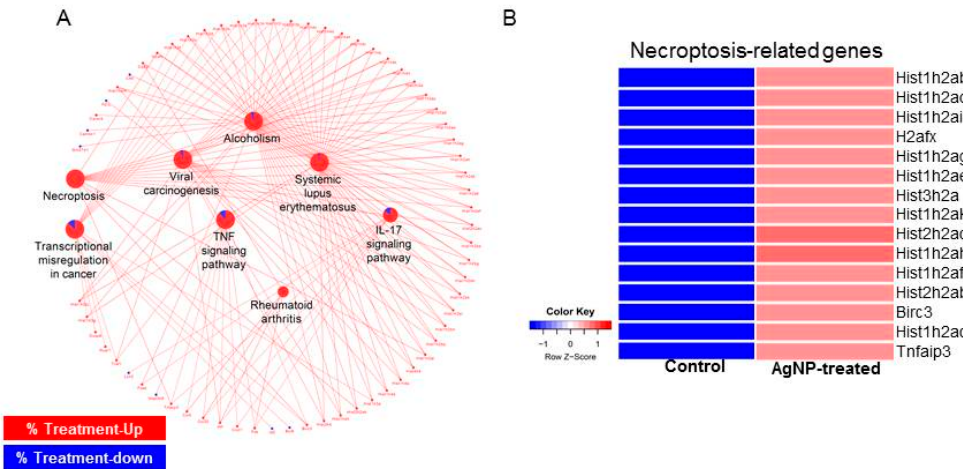
Figure 13. Biological pathways associated cell death are activated by AgNP treatment. ( A ) Network analysis showing aberrantly activated pathways in AgNP-treated NIH3T3 cells. Red and blue in the pie chart of pathway represent the ratio of up- and downregulated genes, respectively. ( B ) Heatmap showing expression level of genes classified in necroptosis pathway.